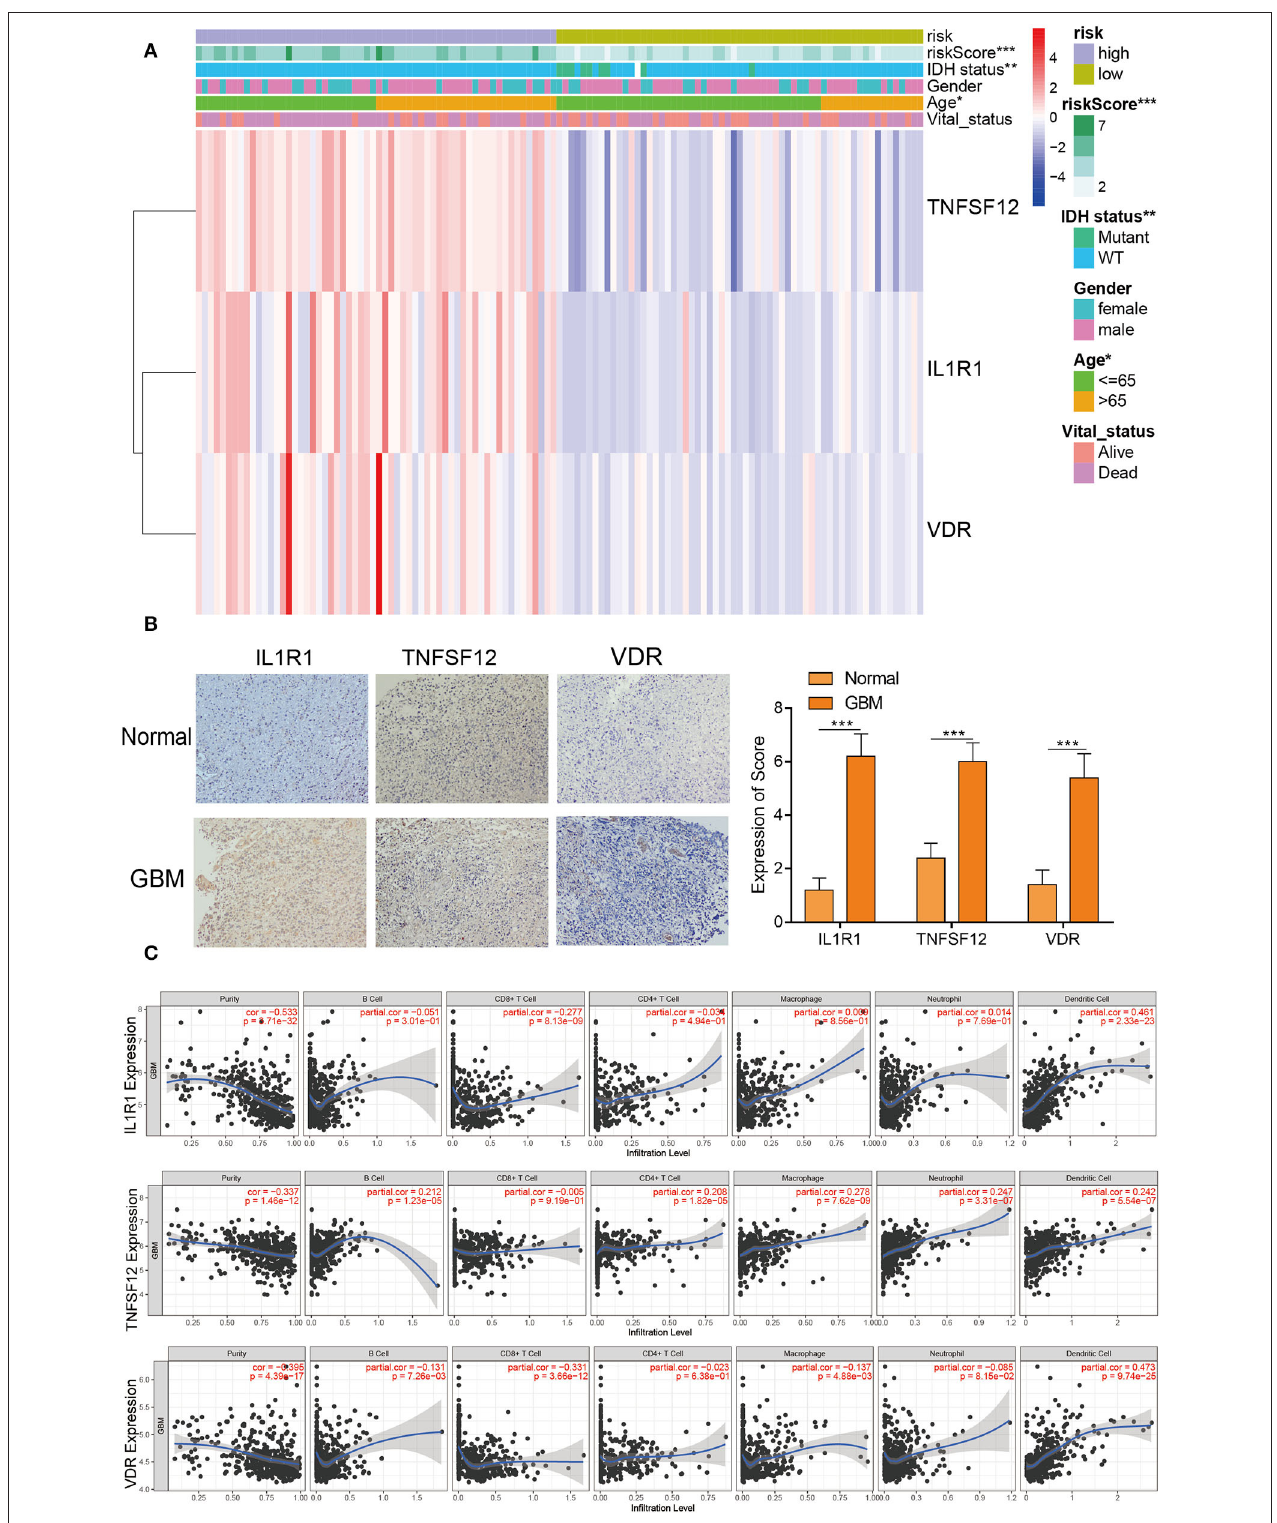
FIGURE 4 | Clinicopathological characteristics and immune infiltration of three hub genes. (A) Heatmap risk clusters with clinical and molecular pathological parameters. (B) The protein expression of VDR , TNFSF12 , and IL1R1 in GBM and normal tissues were tested by IHC. Whole tissue photos are shown (100 × and 400 × ). (C) The relevance between the expression levels of VDR , TNFSF12 , and IL1R1 and the infiltration of macrophages, dendritic cells, and B cells in GBM.